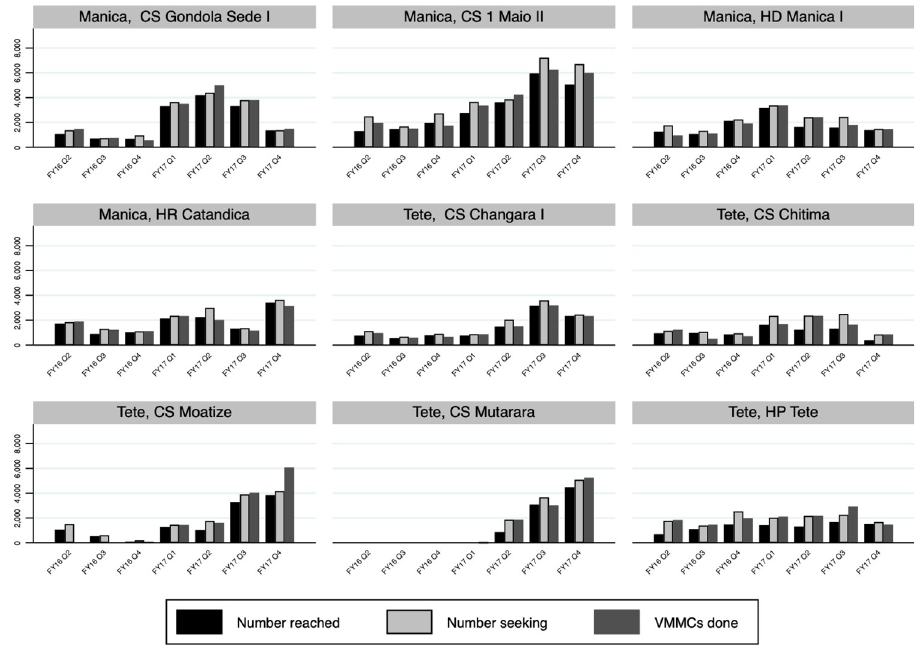
Fig 9. Voluntary medical male circumcisions (VMMCs) cascade in Manica and Tete, Mozambique FY16 Q2- FY17 Q4 by fixed service delivery site. Number reached—number of people reached by VMMC services; number seeking— number of people seeking VMMC services; VMMCs done—number of VMMCs performed. Numbers are totals for fixed service delivery sites and associated outreach sites.